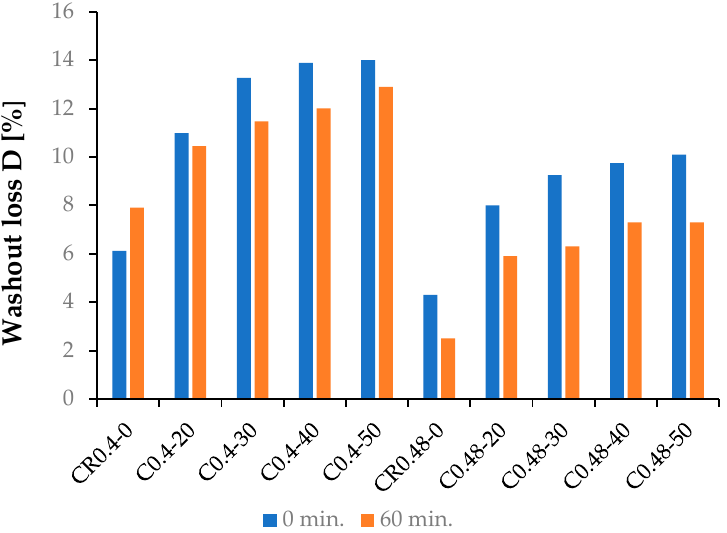
Figure 6. Results of wash-out loss test.